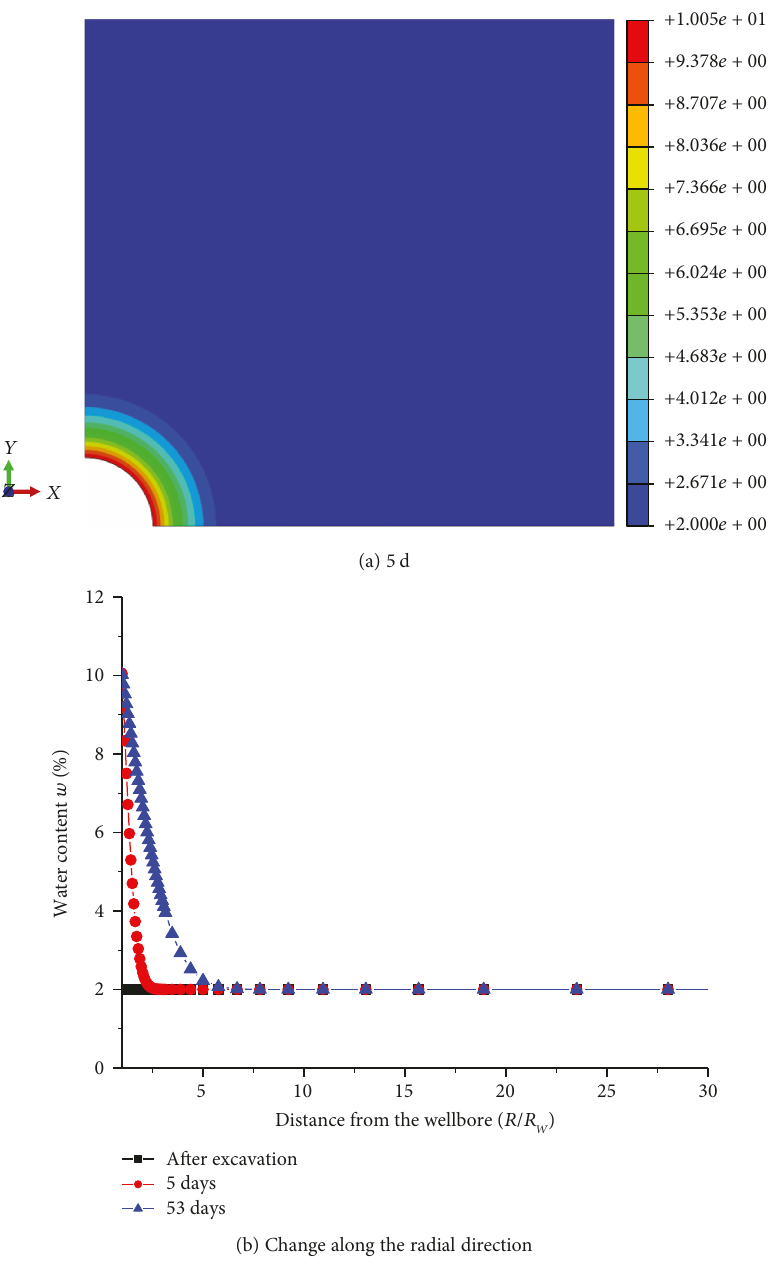
Figure 11: Water content distribution of wellbore after